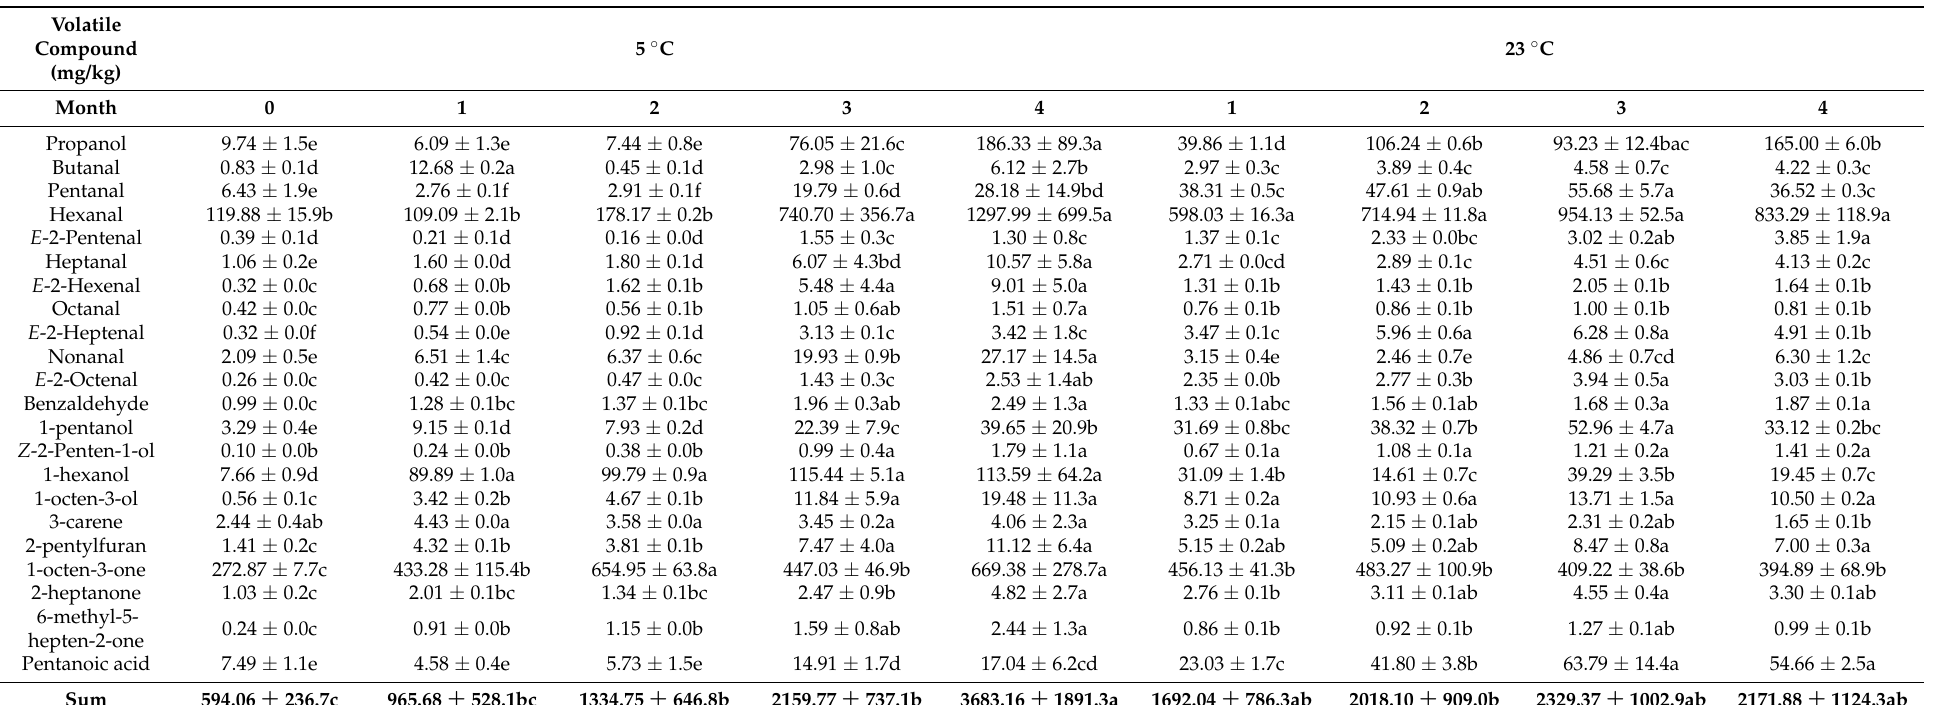
Table 7. Volatile changes in Chandler oil during